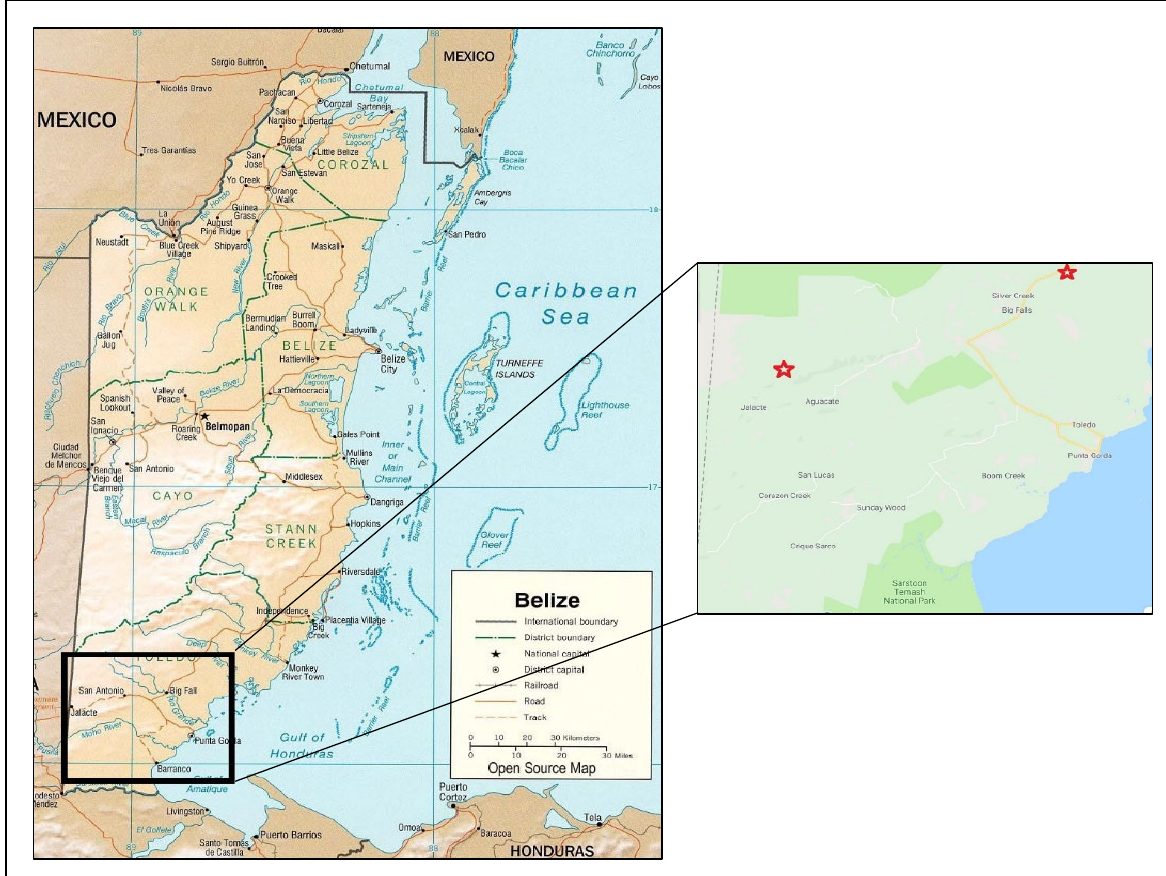
Sources: At Ease in Bellize Ltd., n.d.; Google Map of Pueblo Viejo (left) and Indian Creek (right) villages